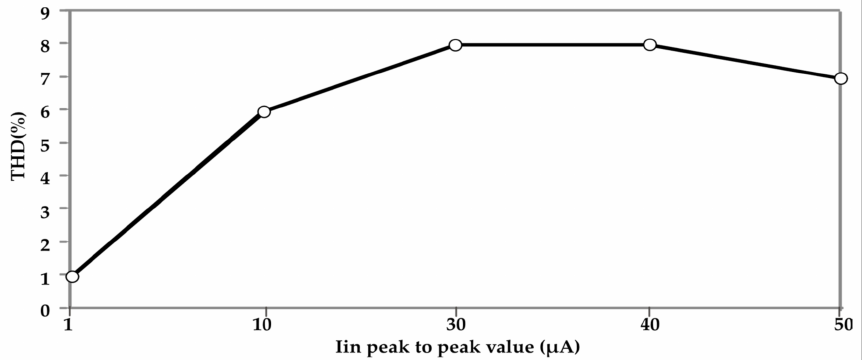
Figure 9. Low-pass (LP) output total harmonic distortion (THD) value for a sinusoidal input signal with frequency of 1 MHz (I con = 50 µ A) at different values of input signal for the filter reported in Figure